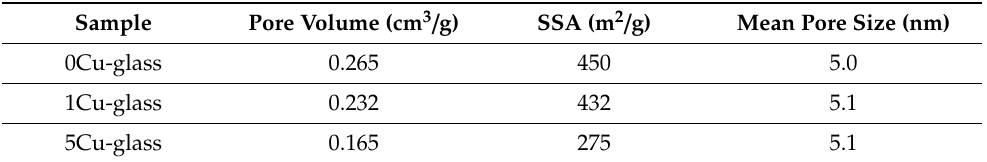
Table 1. Textural characteristics of calcined mesoporous glasses obtained by nitrogen adsorption-desorption porosimetry.